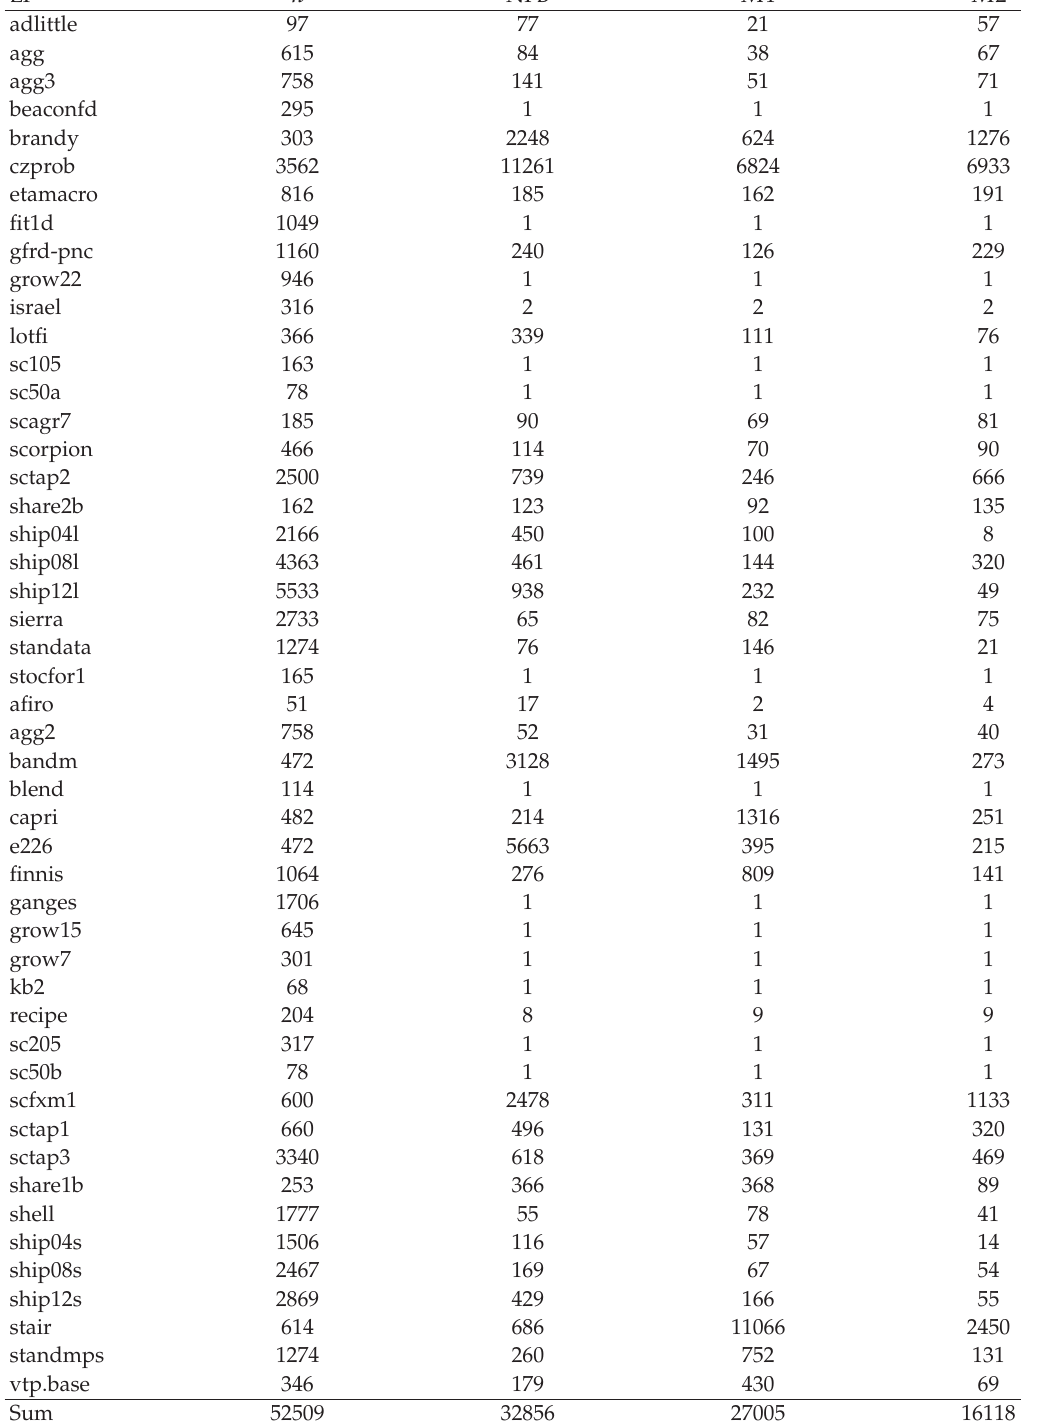
Table 2: Number of iterations for generating the initial solutions